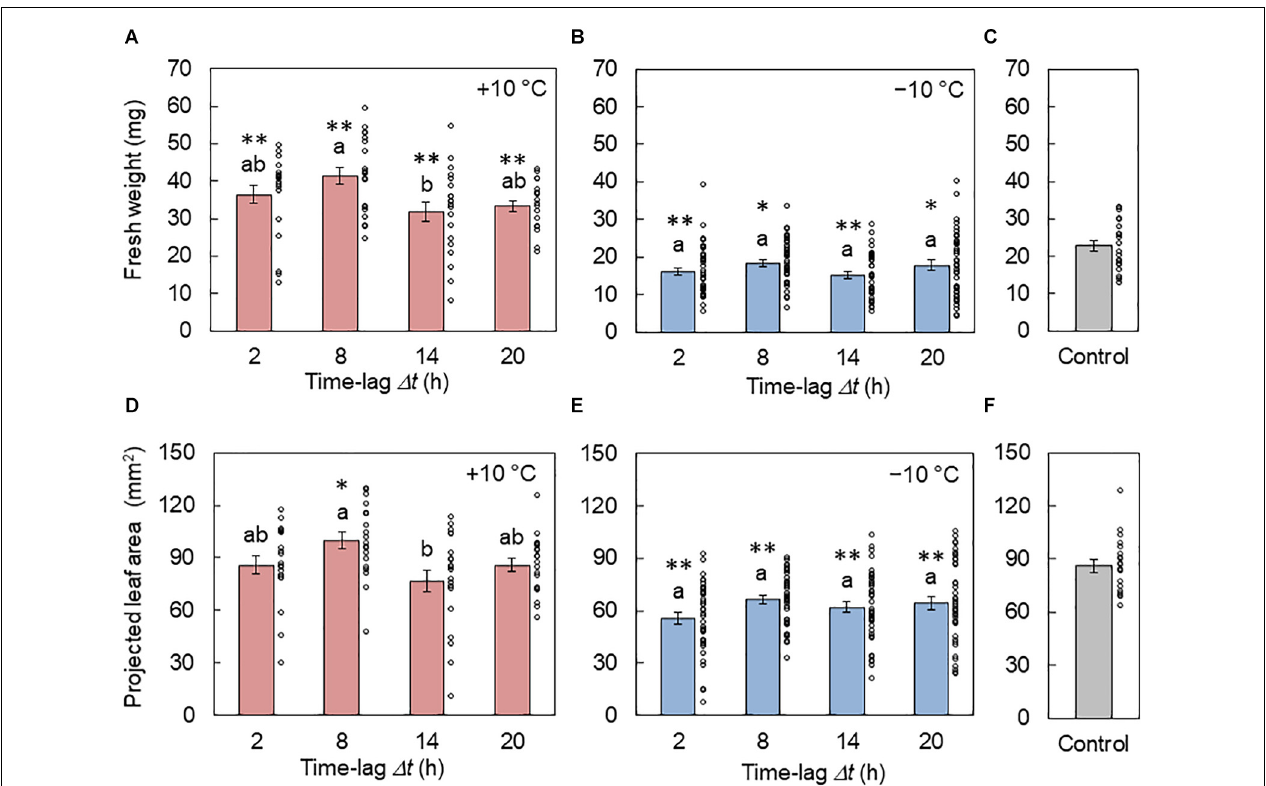
FIGURE 4 | Effect of the time lag on plant growth in conditions of L/D = 16/8 h and 4 h ± 10 ◦ C cycles. (A–C) Fresh weights of the areal part from the +10 ◦ C (A) , − 10 ◦ C (B) , and control (C) conditions (mean ± SEM, n = 20 individuals in (A) and (C) and 40 in (B) ). (D–F) Projected leaf areas from the +10 ◦ C (D) , − 10 ◦ C (E) , and control (F) conditions (mean ± SEM, n = 20 individuals in (D) and (F) and 40 in (E) . The circles indicate the individual data points. Two conditions that do not have the same letter indicate significant differences for each panel (Tukey–Kramer test, p < 0.05). Asterisks indicate significant differences with the control condition